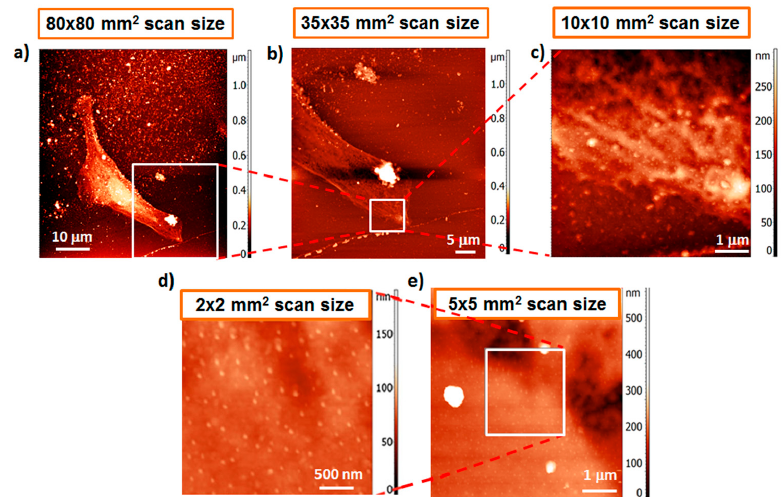
Figure 24. Soft X-ray contact microscopy images of HCV29 cells with 150 nm diameter gold beads obtained after 150 SXR pulses (15 s exposure, a – c ) and 20 SXR pulses (2 s exposure, d , e ) at different scan sizes. Figure modified, based on [85,87].